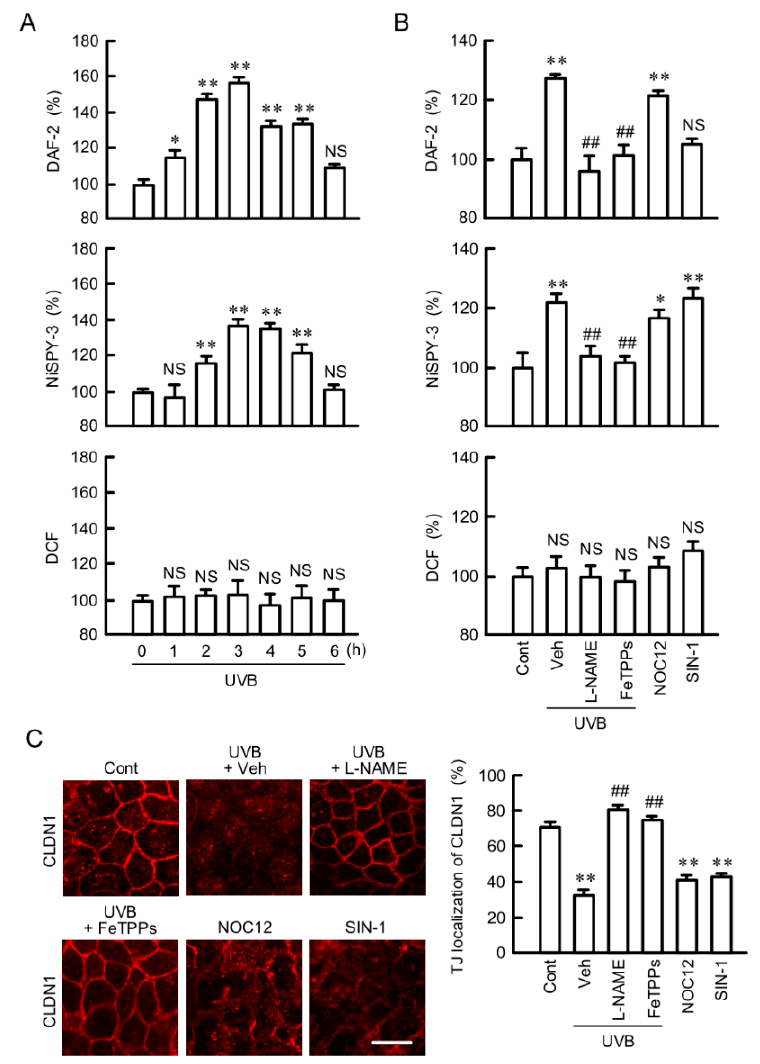
Figure 5. Involvement of reactive nitrogen species (RNS) in the UVB-induced mislocalization of CLDN1. ( A ) After exposing to weak UVB, the cells were cultured for between 0 and 6 h. The cells were incubated with 5 μ M 4,5-diaminofluorescein-2 diacetate (DAF-2DA), 5 μ M 1,3,5,7-tetramethyl-2,6-dicyano-4,4-difluoro-8-[2-(2-hydroxy-2-oxoethoxy)-4-hydroxyphenyl]-3a,4-dihydro-3a-aza-4a-azonia-4-bora(IV)-s-indacene (NiSPY-3), or 5 μ M 2 ′ ,7 ′ -dichlorofluorescein diacetate (H 2 DCFDA) for 30 min. The fluorescence intensities of DAF-2, NiSPY-3, and DCF were measured using a plate reader. ( B , C ) After exposing to weak UVB, the cells were cultured for 3 h ( B ) or 6 h ( C ) in the absence (Veh) and presence of 100 μ M N G -nitro-L-arginine methyl ester (L-NAME) or 5 μ M Fe(III)5,10,15,20-tetrakis(4-sulfonatophenyl)porphyrin (FeTPPs). In the case of UVB-untreated samples, cells were incubated in the absence (Cont) and presence of 10 μ M 1-hydroxy-2-oxo-3-(N-ethyl-2-aminoethyl)-3-ethyl-1-triazene (NOC12) or 250 μ M 3-(4-morpholinyl)sydnonimine hydrochloride (SIN-1). The fluorescence intensities of DAF-2, NiSPY-3, and DCF were measured using a plate reader ( B ). n = 8. The cells were immunostained with anti-CLDN1 antibody ( C ). Scale bar indicates 10 μ m. The fluorescence values of CLDN1 at the TJ are shown as a percentage of the total fluorescence values. n = 4. ** p < 0.01, * p < 0.05, and NS p > 0.05 vs. 0 h, Cont, or Veh. ## p < 0.01 vs. Veh.